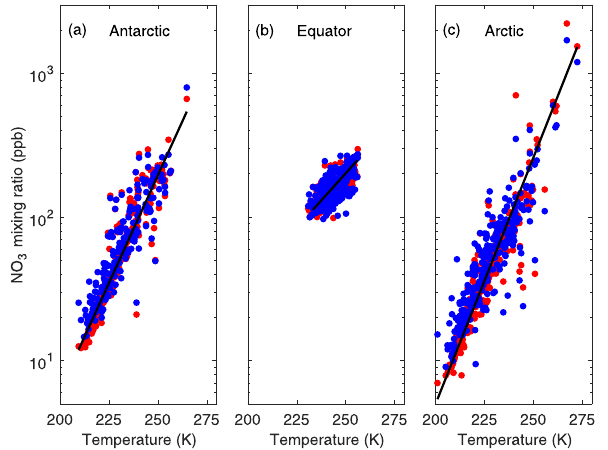
Figure 20. The NO 3 / O 3 ratio from WACCM and from the equilib- rium chemistry theory (see Brasseur and Solomon, 2005) compared to the corresponding ratio from GOMOS. Relative differences. Data are from 5-day time series from 2002 to 2011. A cell with a dot marks a point where there are no collocated